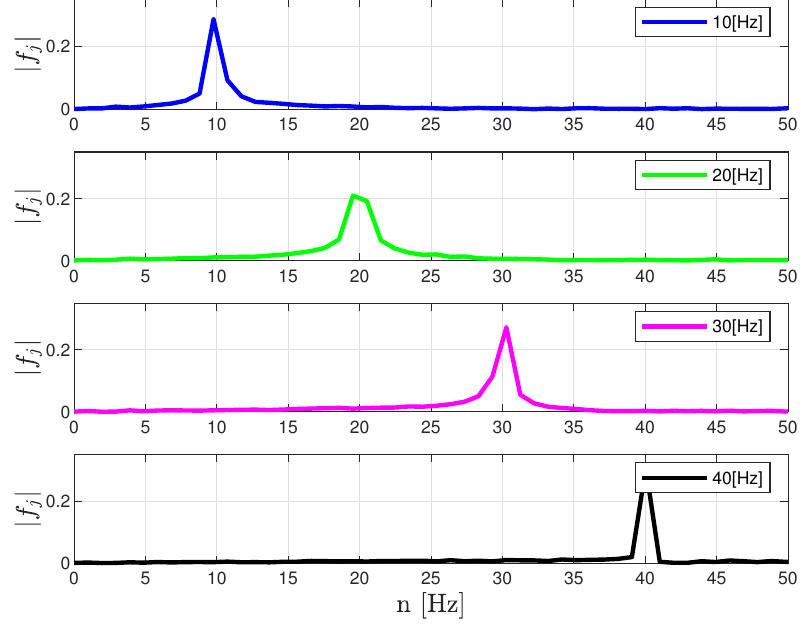
Figure 9. Amplitude and frequency of